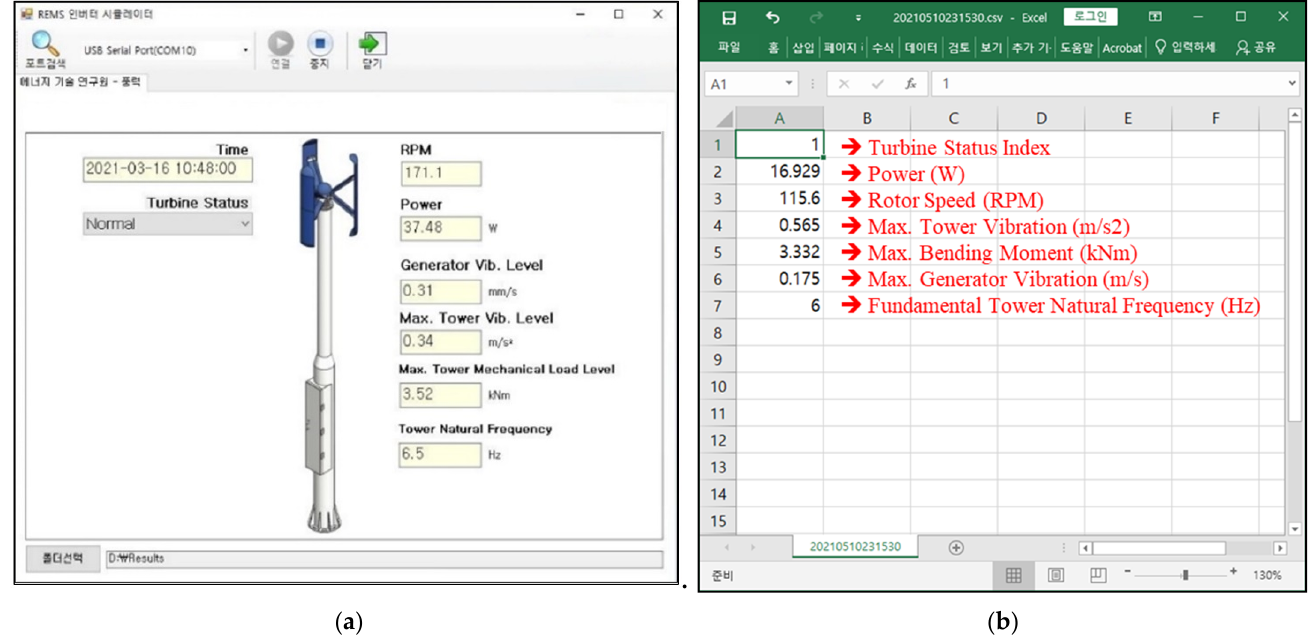
Figure 14. Health monitoring and diagnosis system for the small H-type Darrieus VAWT: ( a ) screenshot of the health monitoring and diagnosis system; ( b ) an example of the result file for each 1-minute time interval along with its description. Table 3. Description of turbine status index.